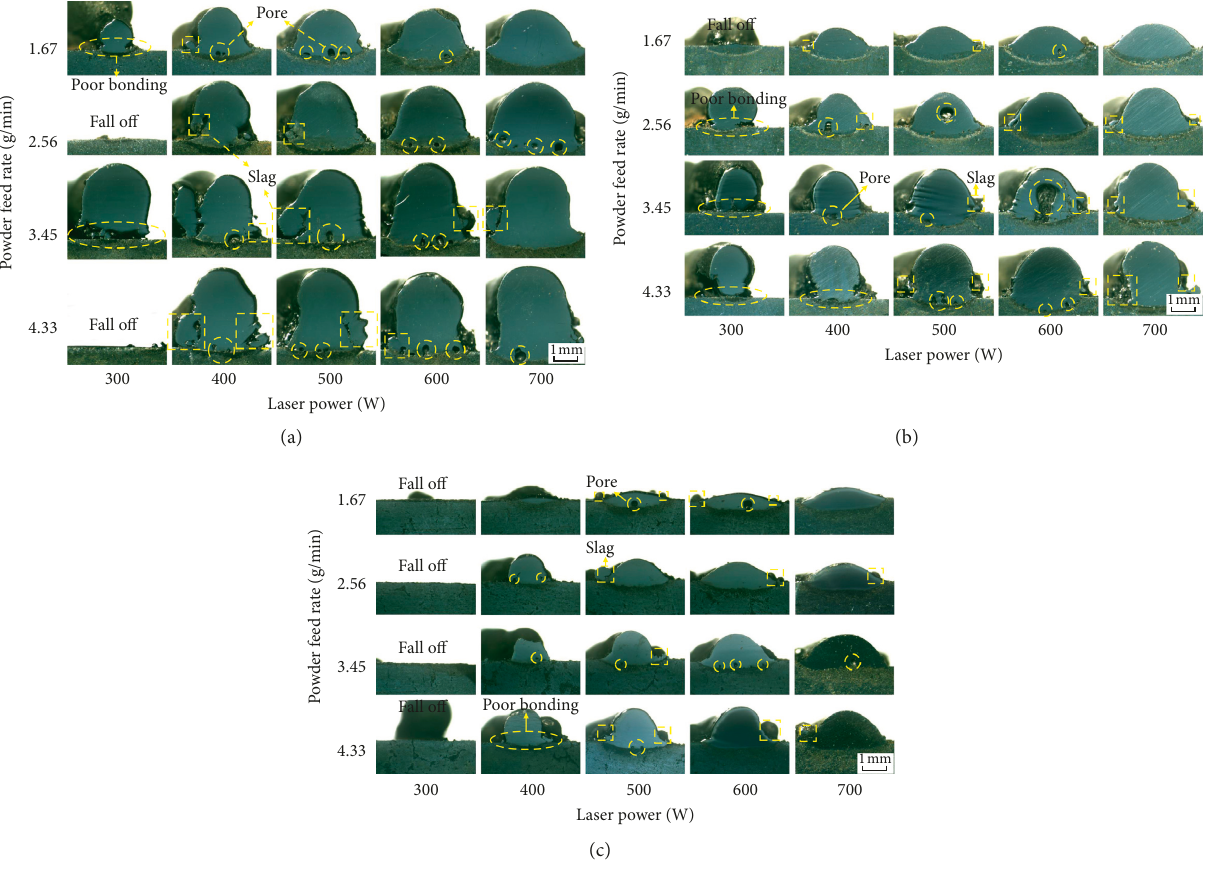
Figure 5: Cross section of laser tracks for laser cladding on compacted graphite cast iron at the scanning velocity of (a) 3 mm/s, (b) 5mm/s, and (c) 7mm/s.